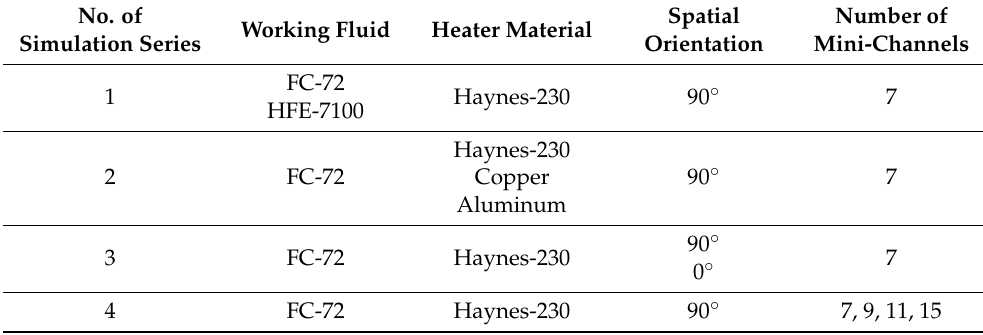
Table 5. Overall characteristics of the data used in the numerical simulations. No.